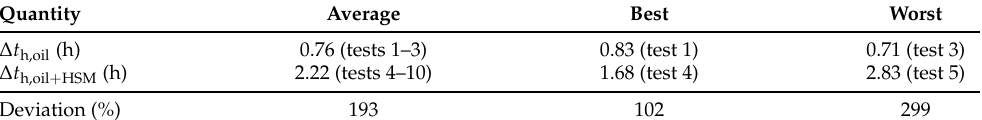
Table 8. Heating time evaluation of the tests with silicone oil and with silicone oil + HSM. Quantity